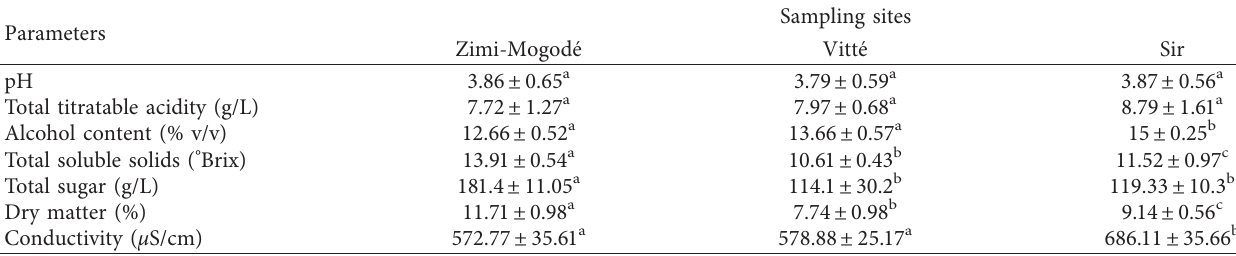
Table 3: Physicochemical profile of the “T´ea L´emi” wine from the Far-North of Cameroon.